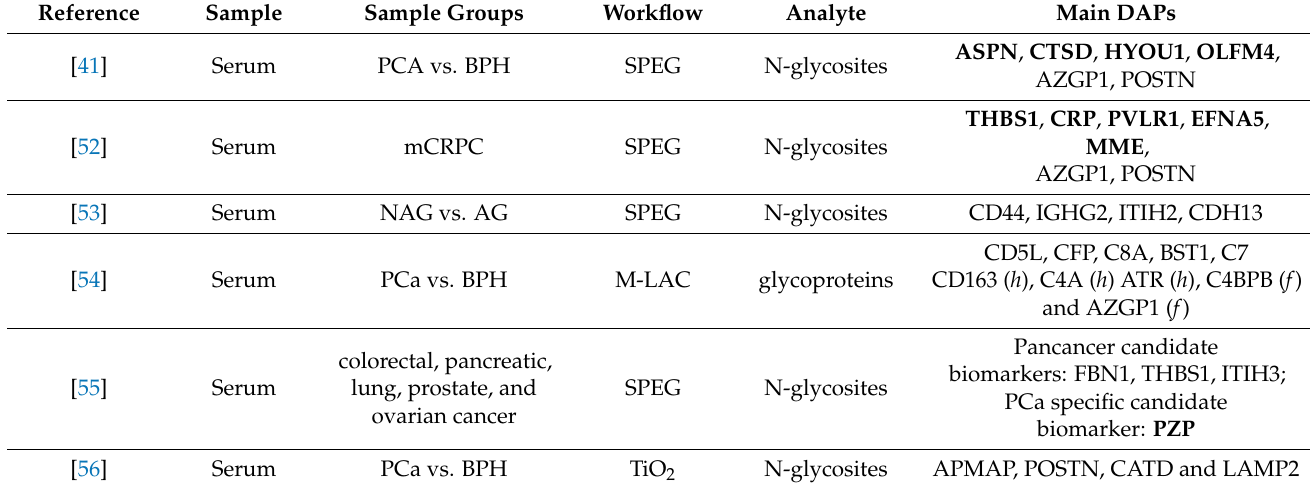
Table 4. Main differentially abundant glycoproteins (DAPs) identified in PCa urine sample by MS-based workflows. Plain text = discovery level; bold character = validation level; italic = protein is downregulated; ( f ) core-fucosylated glycopeptide; ( g ) glycopeptide, ( h ) highly branched